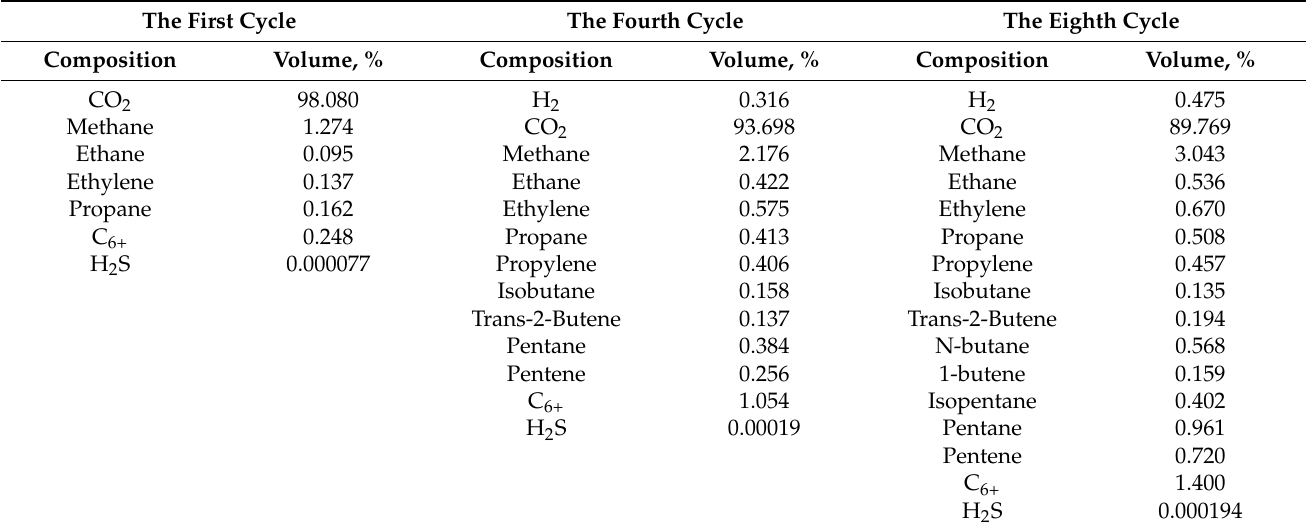
Table 3. Results of gas chromatography during the CSS process.